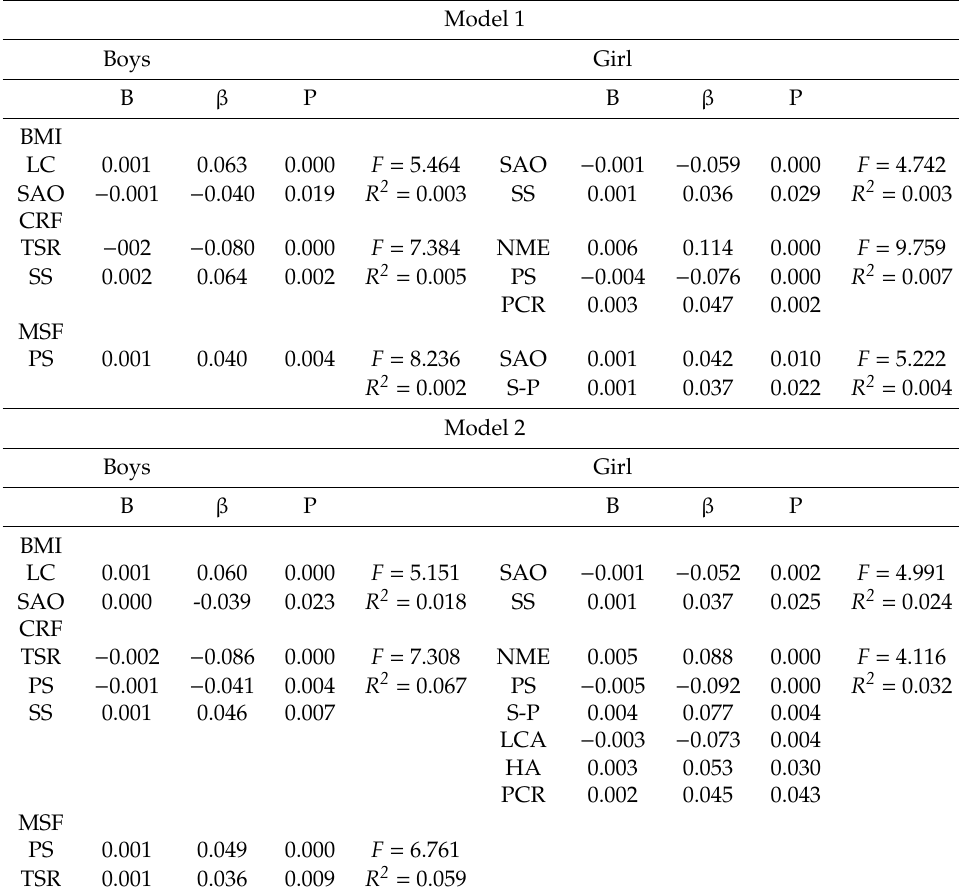
Table 3. Relationships between BMI, Physical Fitness, and Quality of Life. Model